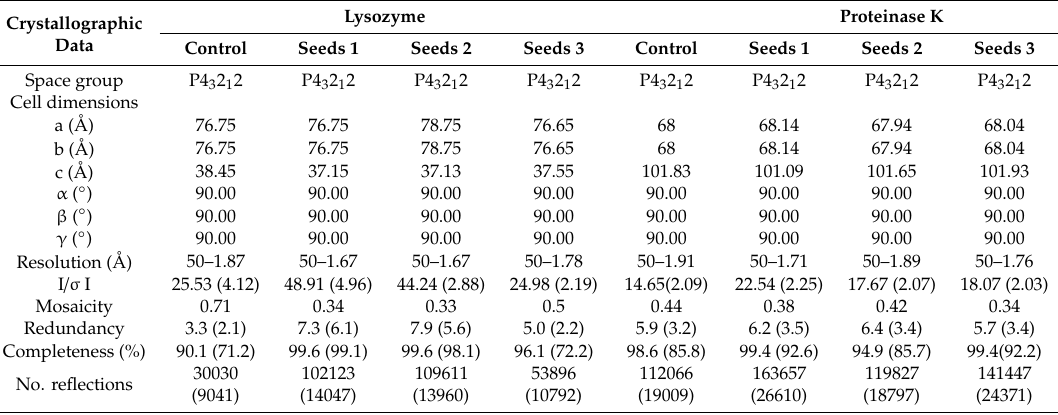
Table 2. Optimal di ff raction data of lysozyme and proteinase K crystals obtained from di ff erent conditions.